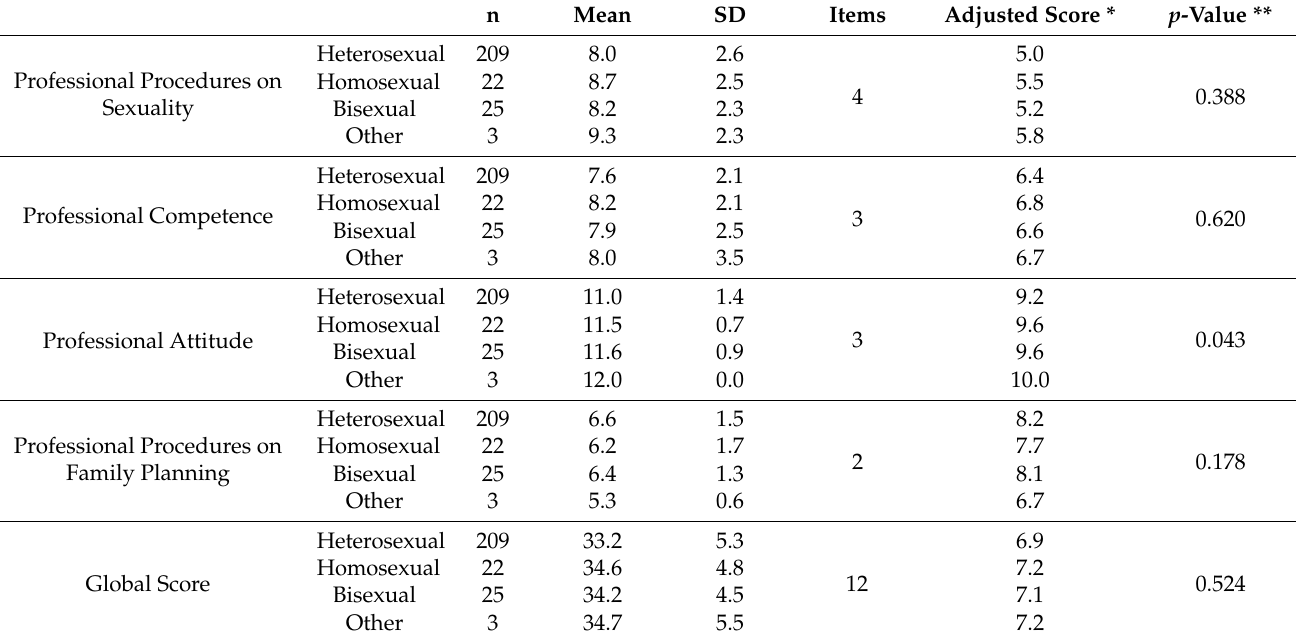
Table 13. Scores regarding the sexual orientation of the participants.